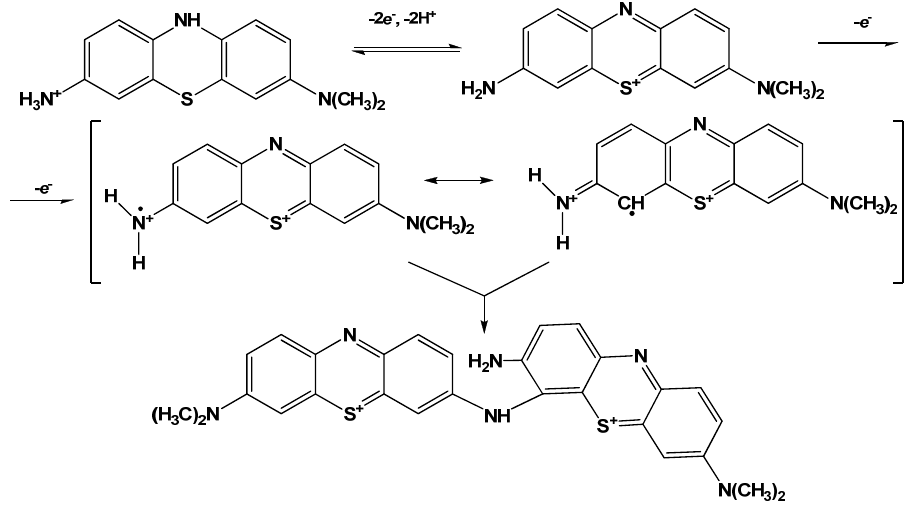
Figure 4. It involves the formation of cation radicals followed by their coupling and stabilization by hydrogen ion release.